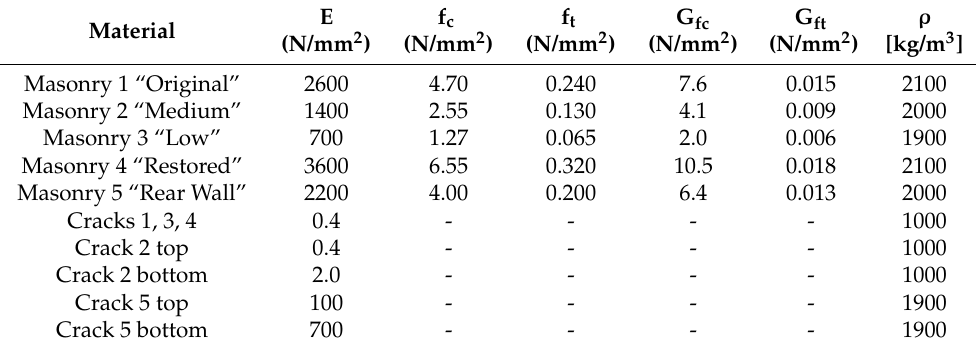
Table 2. Material properties of the different qualities of masonry considered in the numerical